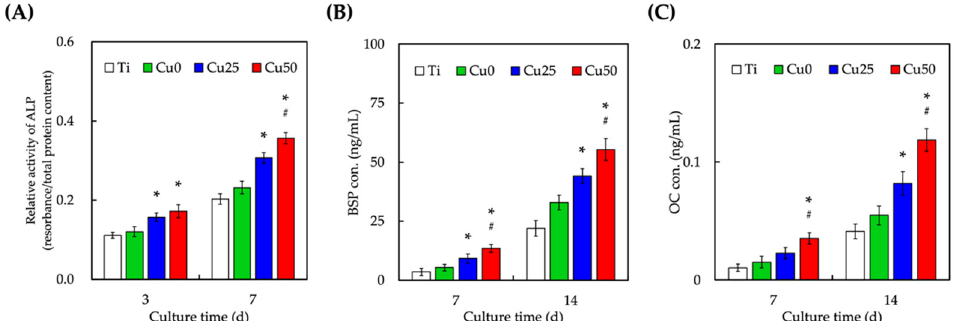
Figure 11. Osteogenic-related differentiation marker of ( A ) ALP, ( B ) BSP and ( C ) OC expression of WJMSCs cultured on different TiPCu scaffolds at 7 and 14 days. * indicates a significant difference ( p < 0.05) from the Cu0 group. # indicates a significant difference ( p < 0.05) from the Cu25 group. Data are presented as mean ± SEM, n = 6 for each group.